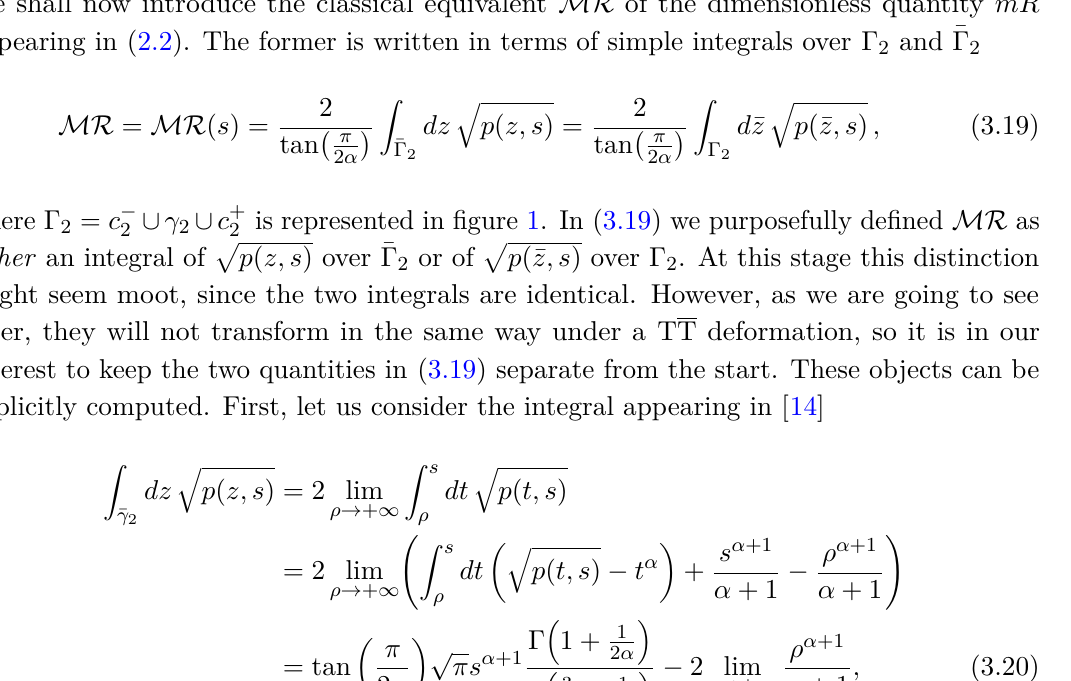
with the image of γ 1